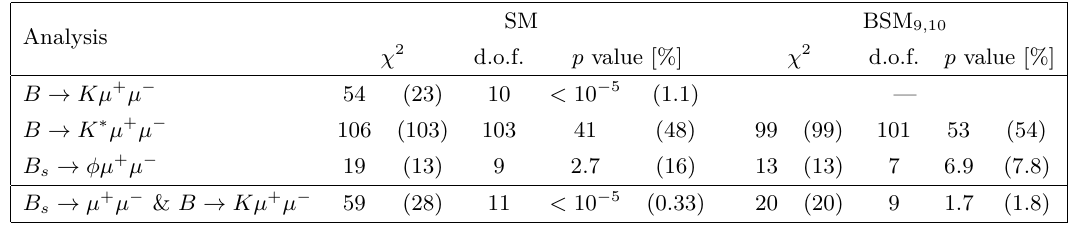
Table 5 . Summary of the goodness of fit at the respective best fit points for the individual analyses. We provide two sets of values, the main numbers include both the theory priors and the experimental likelihoods, while the values in parenthesis only account for the